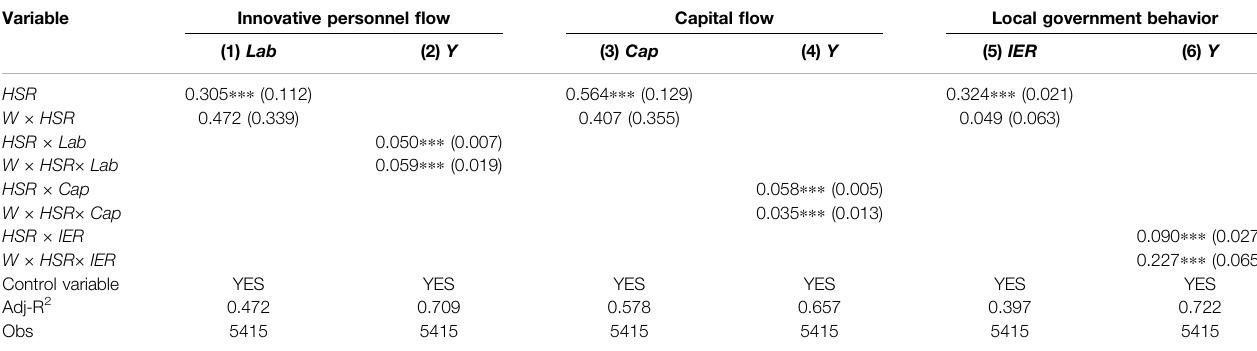
TABLE 4 | Mechanism test results.